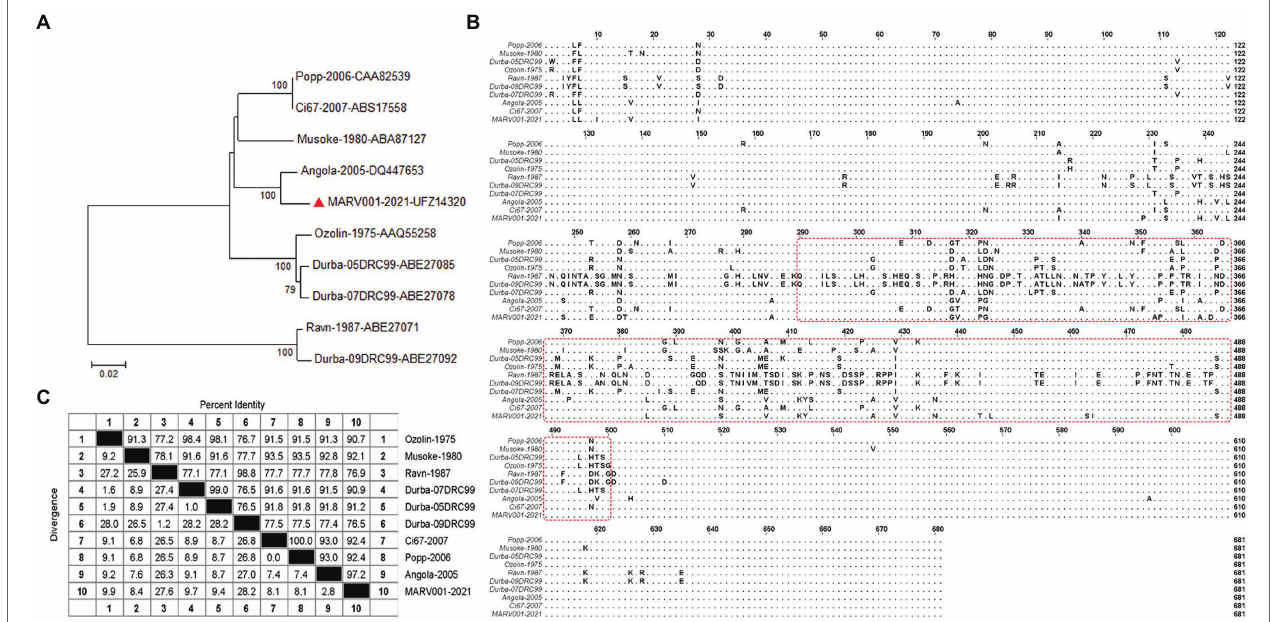
FIGURE 3 | Phylogenetic analysis of representative strains of MARV (A) The amino acid sequence of MARV GP in the GenBank database was analyzed using MEGA (version 7.0.20). The Jones–Taylor–Thornton (JTT) model was the optimal amino acid substitution model. Phylogenetic analysis used a neighbor-joining tree and 1,000-repeat bootstrapping. The ruler at the bottom of the dendrogram indicates the number of nucleotide substitutions per site. Horizontal branch lengths are proportional to the genetic distance between sequences. Individual strains consist of the name and GenBank accession number, and the numbers on the left branch are percentages of bootstrap values. The red triangles represented the most recently discovered strains in 2021. (B) The figure is a multiple sequence alignment of GP amino acids for representative strains in (A) . MARV GP is mainly composed of GP1, Mucin, and GP2. The amino acid differences are mainly concentrated in the Mucin part. The red box outlines the amino acid sequence (aa290-500) within the mucin-like domain. (C) Analysis of amino acid sequences among MARV strains. That shows the homology of GP amino acids among different strains. The upper half of the dividing line represents the homology of GP amino acid sequences between MARVs, and the lower part represents the differences. The numbers correspond to different